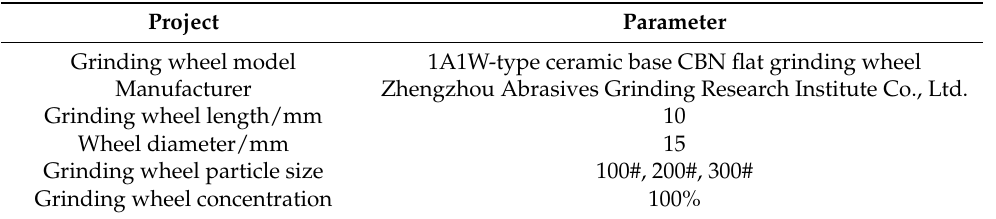
Table 3. Grinding wheel specifications.